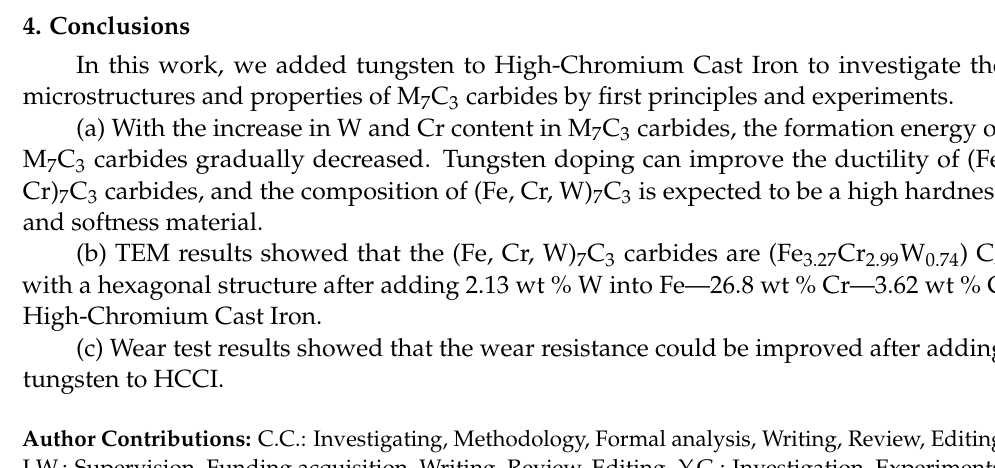
Figure 11. The worn surfaces of HCCI: ( a , c ) ordinary HCCI; ( b , d ) tungsten-bearing HCCI.